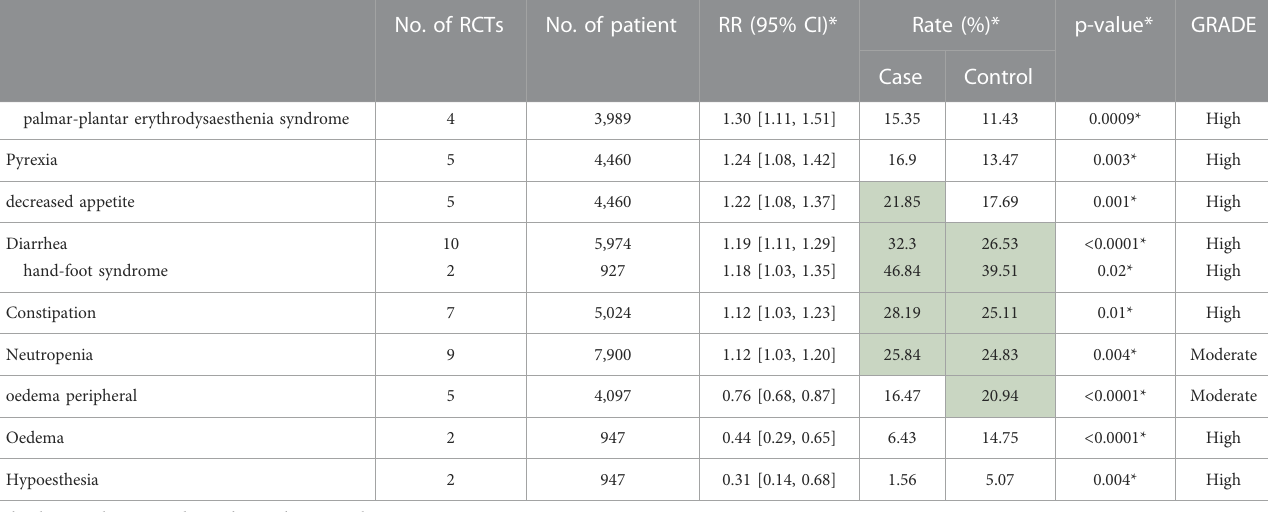
*The above results are sorted according to the RR, results. *Results with RR ≥ 5 have been highlighted and bolded. Results with 5 > RR ≥ 2 and RR ≤ 1have only been